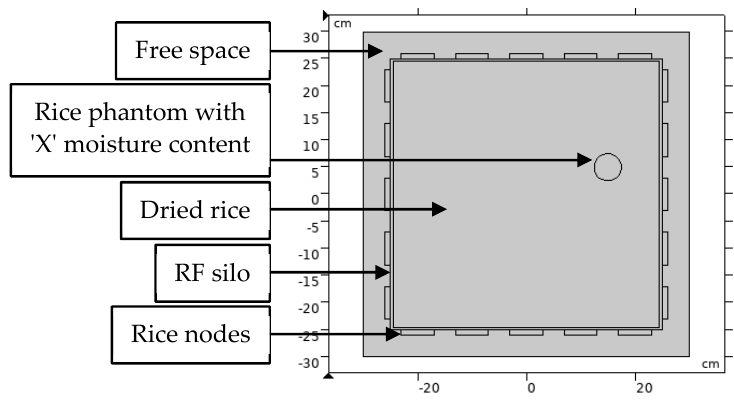
Figure 2. Configuration of the RTI system.